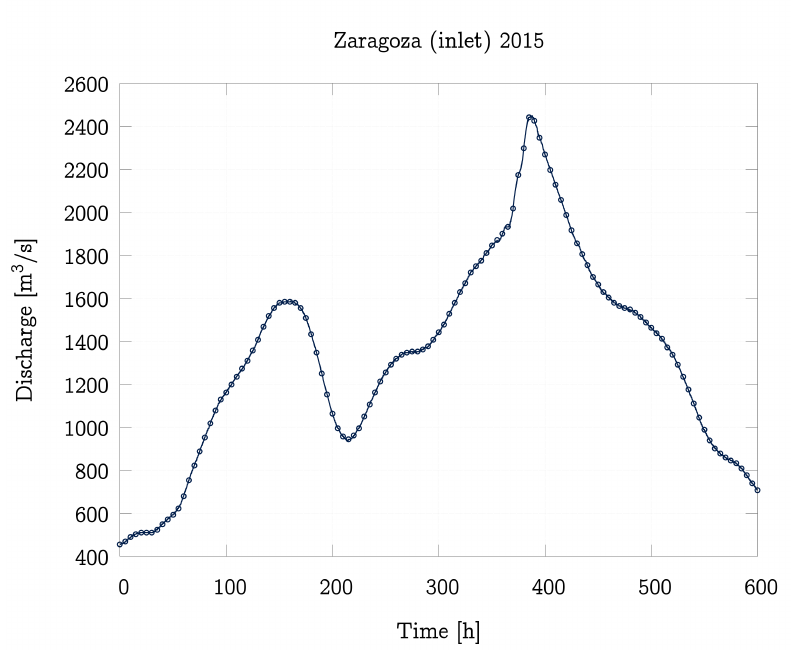
Figure 6. Inlet hydrograph for the Ebro River flood event in 2015 in Zaragoza (A011).